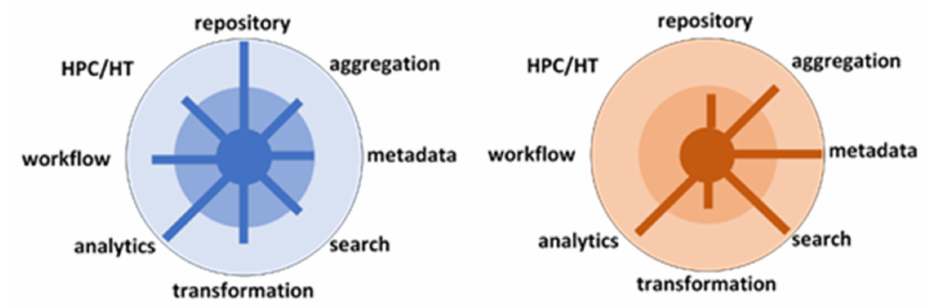
Figure 3. Illustration of two possible extension scenarios emerging from small functional nuclei. In the left diagram, functionality is added in the direction of workflow support and analytics on powerful machines, while the right is directed towards metadata search and analytics on aggregated